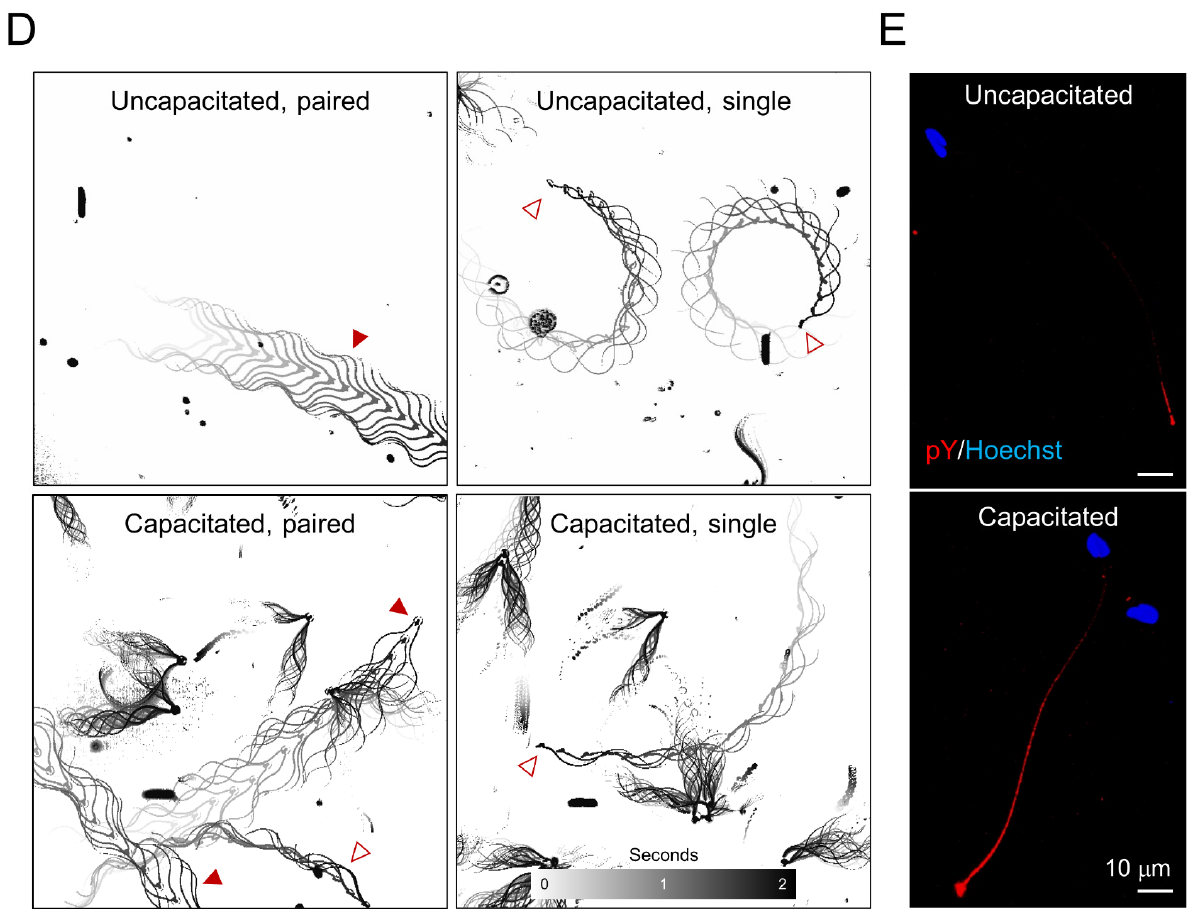
Figure 3. Capacitation induces changes in the motility pattern of gray short-tailed opossum sperm and tyrosine phosphorylation. ( A ) Flagellar waveform analysis. Sperm heads were tethered to the glass coverslips, and their tail beating was recorded from uncapacitated (left) and capacitated (middle and right) sperm. One flagellum of the paired sperm (middle) and an unpaired sperm flagellum (right) beat asymmetrically (arrowheads) after incubation under capacitating conditions. Flagellar waveforms from two-beat cycles were overlaid, and each frame was color-coded. ( B , C ) Quantitative comparisons of maximum angle of the primary curvature ( B , α -angle) and beating frequency ( C ) of opossum sperm flagella. The α -angle (the red angles in sperm cartoon) and beat frequency were measured from paired (circles) and single (squares) sperm cells before (black) and after (red) inducing capacitation. α -angle of the uncapacitated sperm (0 min, paired, 51.0 ◦ ± 1.7 ◦ ; unpaired, 48.3 ◦ ± 2.7 ◦ ) increases after inducing capacitation for 90 min (90 min, paired, 63.7 ◦ ± 1.9 ◦ ; single; 82.1 ◦ ± 5.5 ◦ ). α -angle in single sperm is significantly larger than that in paired sperm after inducing capacitation. The beat frequencies of uncapacitated (0 min, paired, 16.3 ± 0.8 Hz; single, 15.8 ± 1.8 Hz) and capacitated (90 min, paired, 15.3 ± 0.9 Hz; single, 11.1 ± 1.5 Hz) opossum sperm were compared. n.s, non-significant, * p < 0.05, *** p < 0.001. Data are represented as mean ± SEM. ( D ) Swimming trajectories of the opossum sperm. Uncapacitated (top) and capacitated (bottom) opossum sperm were subject to free swimming under 0.5% methylcellulose, and swimming trajectories were drawn by overlaying time-lapse frames. Paired sperm swim in a straight line regardless of inducing capacitation (left). By contrast, unpaired single sperm swim in circles (right-top) with increased radius after capacitation is induced (right-bottom). Filled and empty arrowheads indicate free-swimming paired and single sperm, respectively. ( E ) Confocal images of the phosphotyrosine (pY)-immunostained opossum sperm. pY in opossum sperm were imaged before (top) and after (bottom), inducing capacitation. Hoechst was used for counterstaining. See also Videos S1 and